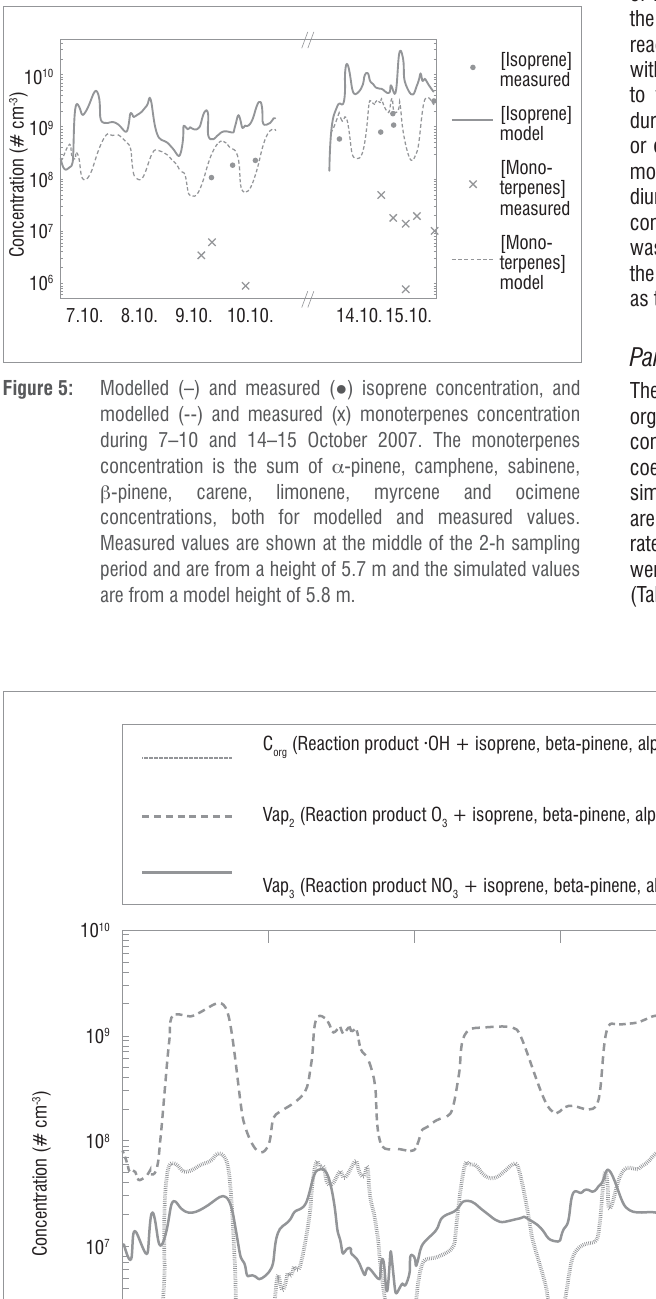
and NO during 7–10 and 14–15 3 3